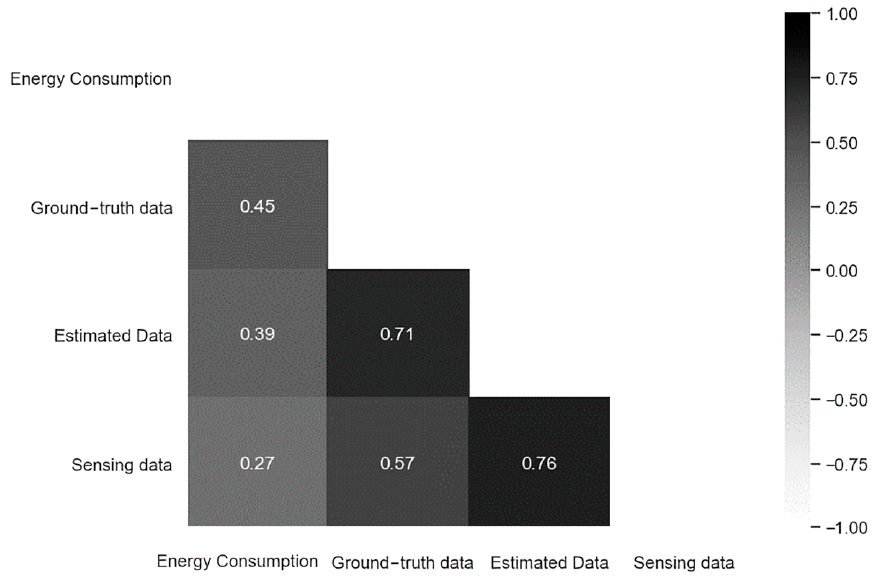
Figure 15. Correlation analysis of occupancy and energy consumption.